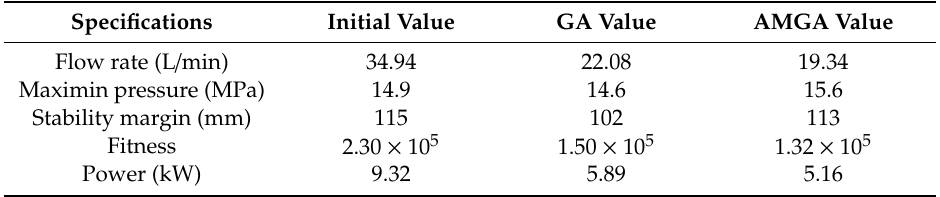
Table 5. Specifications of di ff erent